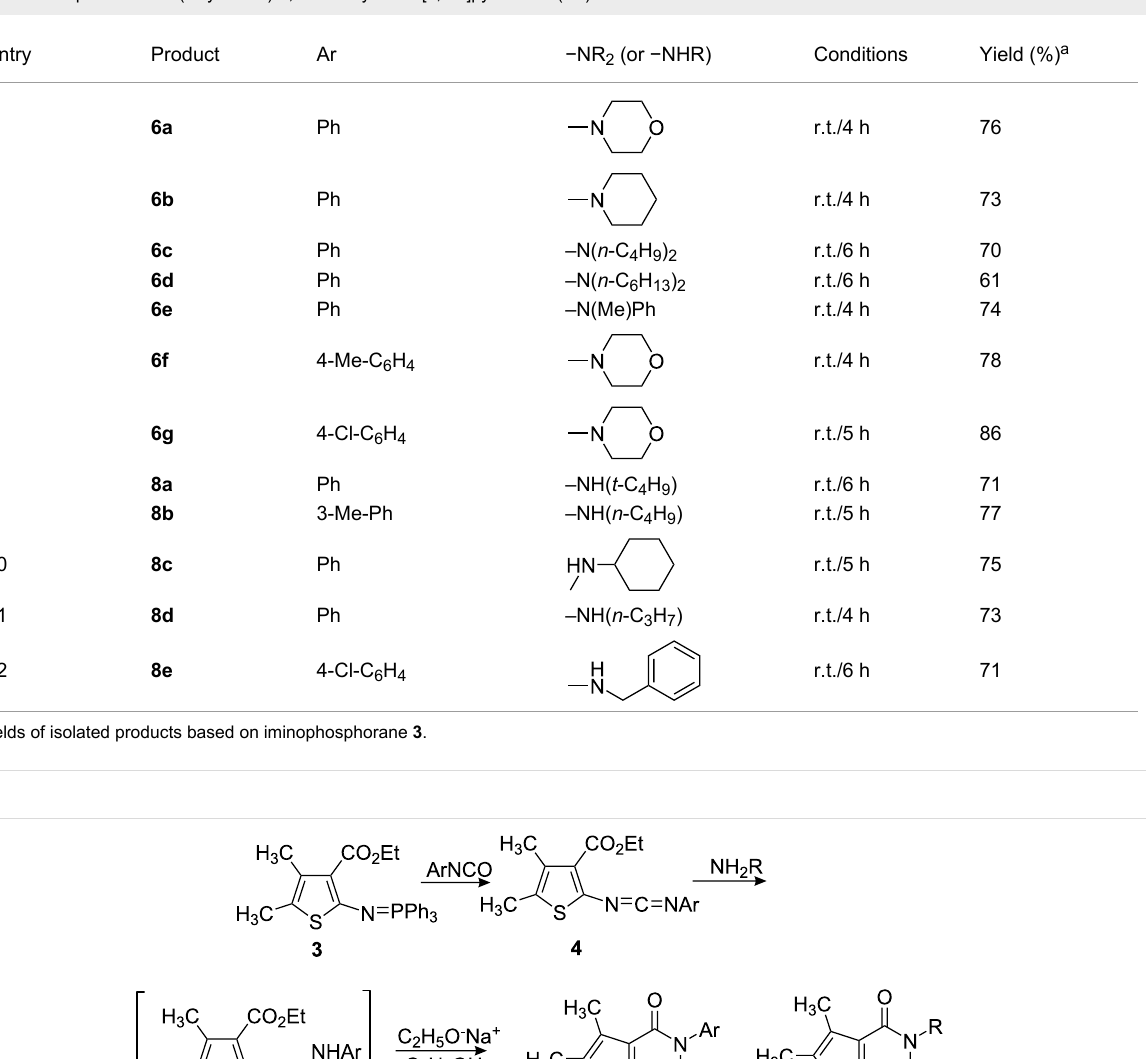
Table 1: Preparation of 2-(alkylamino)-5,6-dimethylthieno[2,3- d ]pyrimidin-4(3 H )-ones.